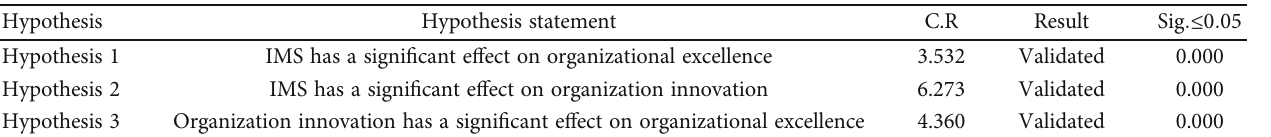
Table 12: Hypothesis validation and signi fi cance.